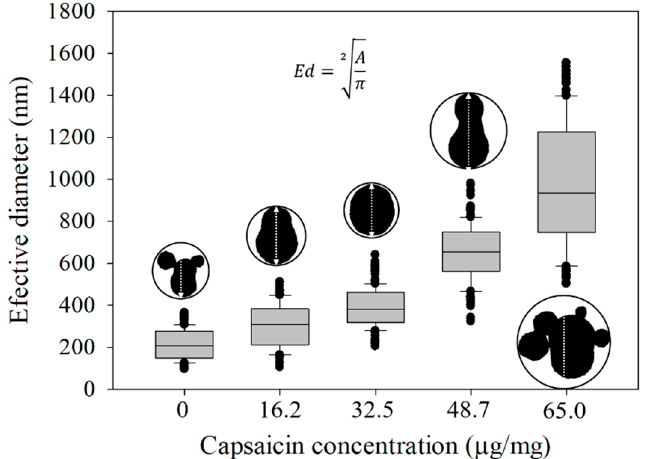
Figure 5. Effective diameter of the isolated nanoparticles showed an increasing tendency with respect to the concentration of capsaicin. The equation of effective diameter ( Ed ) is also displayed. Conditions: digital measurement of n = 180 nanoparticle images at 1376 × 1032 pixels and 8 bits of compression; resolution set at 2.1 pixels/nm. Values are the means of three experimental replicates ± standard deviations.